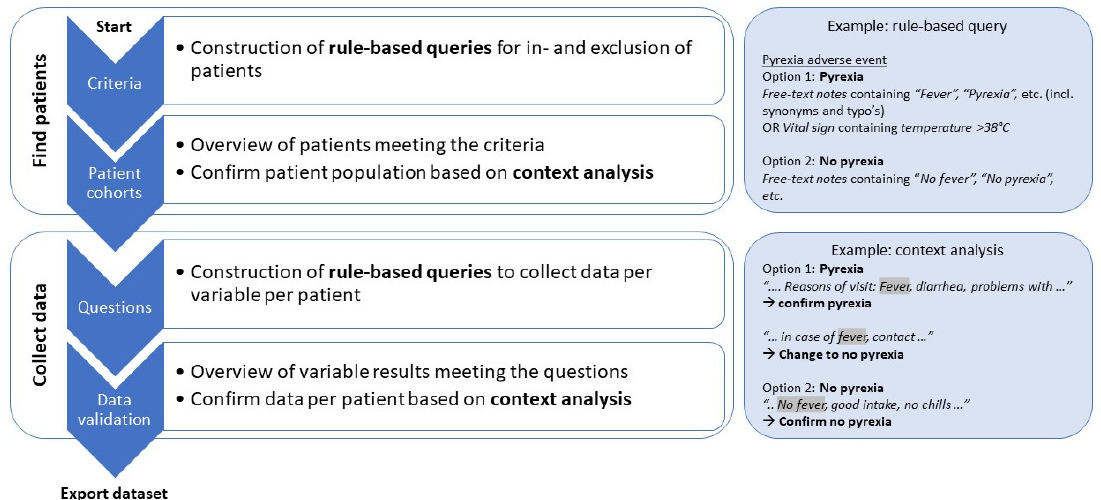
Figure 1. Steps taken to find patients and collect data with the text ‐ mining tool, including the construction of rule ‐ based queries and context analysis.